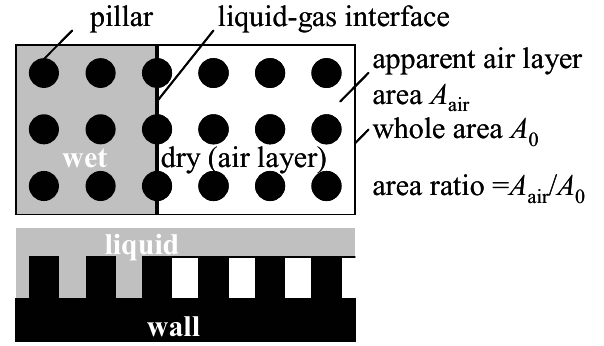
Fig. 5 Area ratio of air